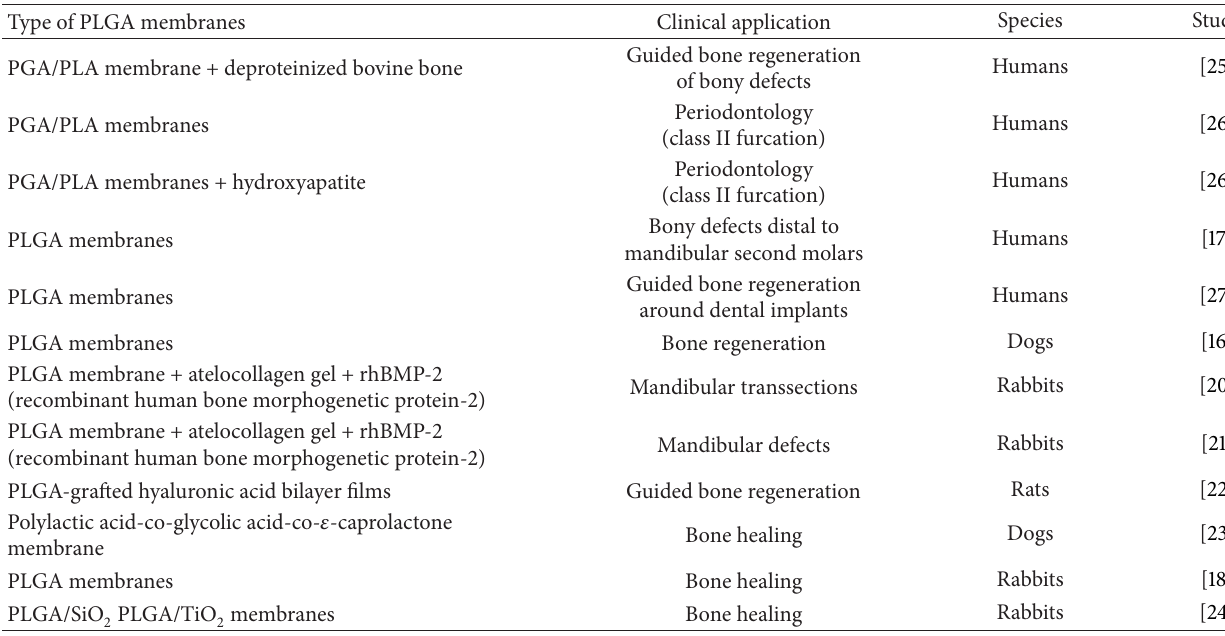
Table 1: PLGA membranes in animal and human